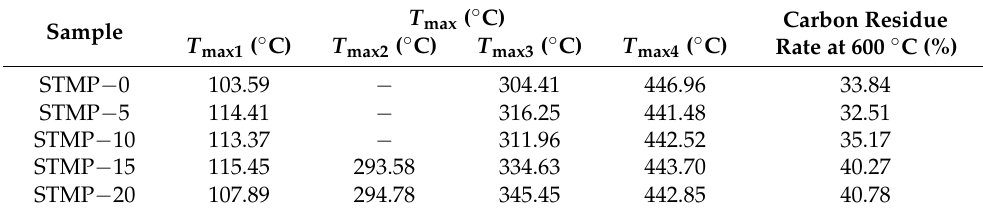
Table 3. Thermal properties of STMP crosslinked hemicellulose